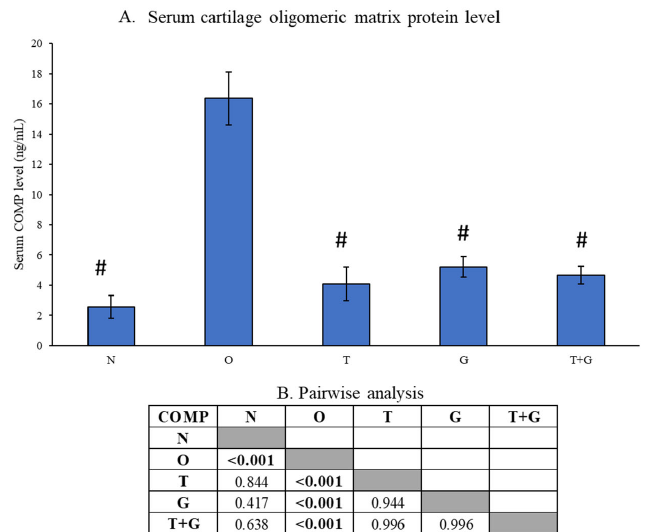
Figure 5. Serum level of cartilage oligomeric matrix protein (COMP) of the rats ( A ). The results of inter ‐ group comparison ( p ‐ values) obtained from the Tukey post hoc test are depicted in ( B ). The significant difference is defined at p < 0.05. Abbreviation: #: significant difference compared to the O group; N: normal control; O: osteoarthritis control; T: palm TRF ‐ treated group; G: glucosamine sulphate ‐ treated group; T + G: palm TRF + glucosamine sulphate ‐ treated group.